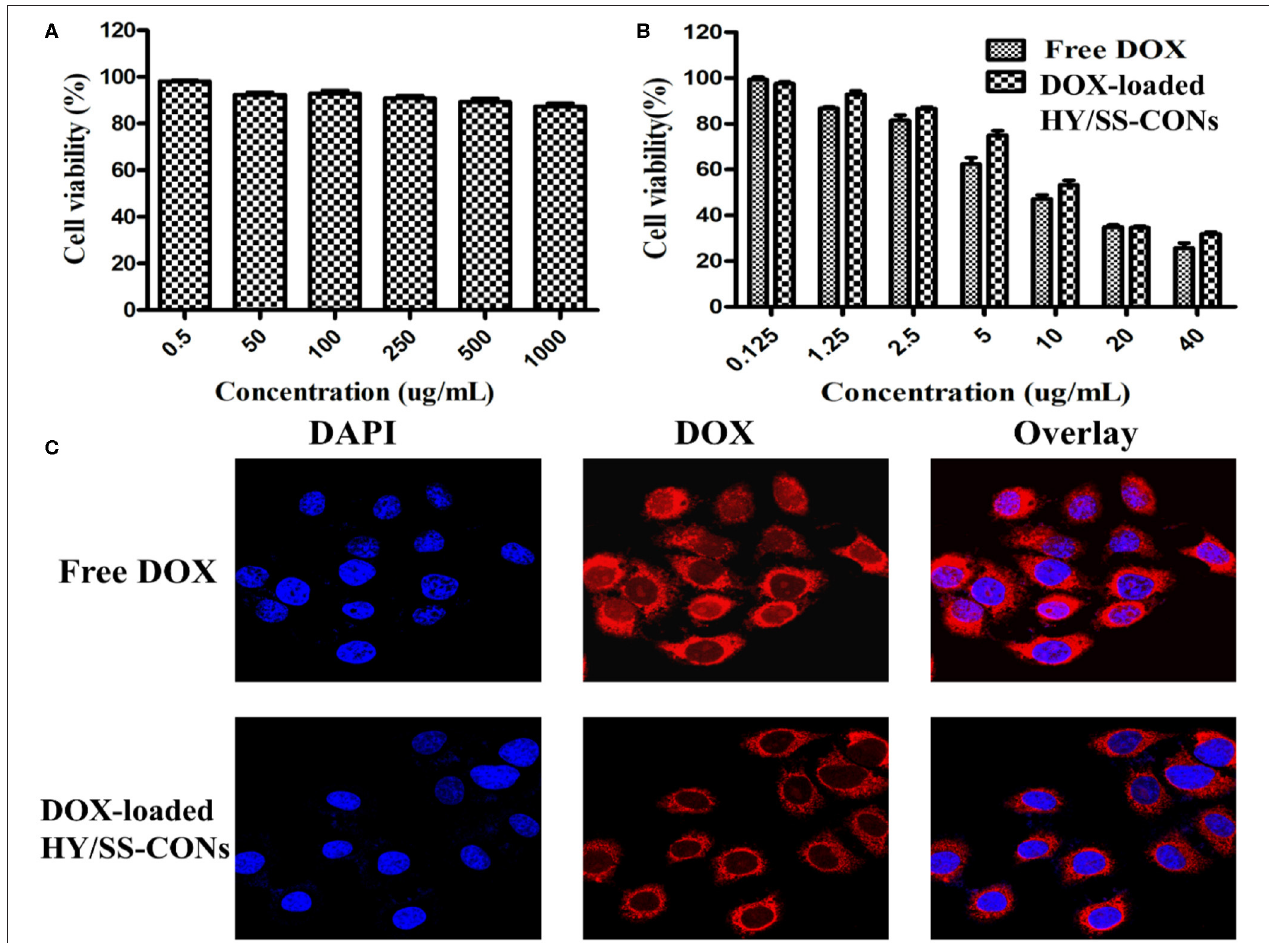
FIGURE 5 | In vitro cytotoxicity and cell uptake. (A) Viability of HepG2 cells treated with drug-free HY/SS-CONs; (B) Cytotoxicity of free DOX and DOX-loaded HY/SS-CONs against HepG2 cells; (C) Representative fluorescence microscopy images of HepG2 cells treated with free DOX and DOX-loaded HY/SS-CONs for